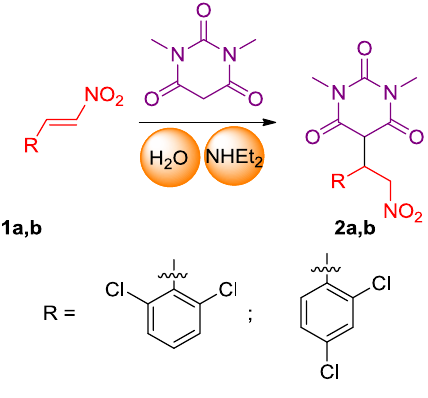
Figure 1. ORTEP diagrams of the structures of 1a and 2a , b